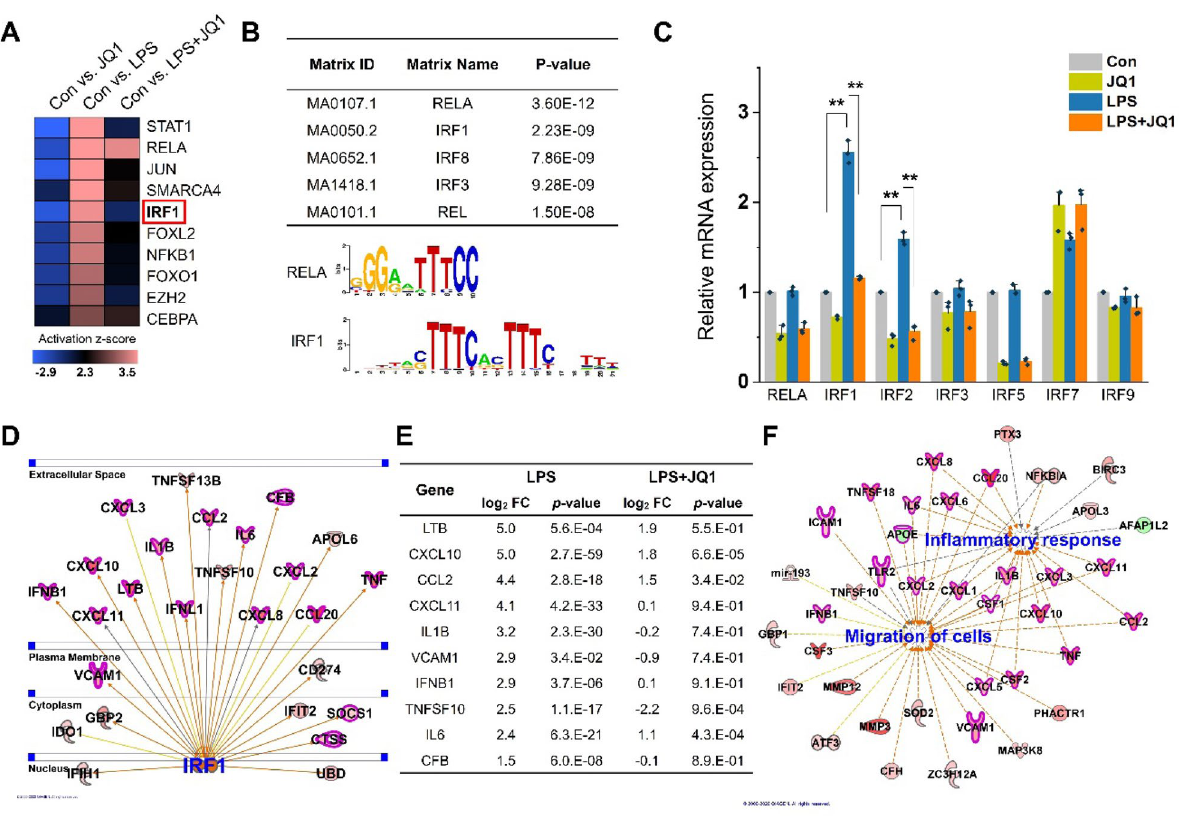
Figure 5. IRF1 regulates migration-related genes in LPS- and LPS + JQ1-treated HMC3 cells. ( A ) IPA upstream regulator analysis of DEGs in LPS-, JQ1- and LPS + JQ1-treated HMC3 cells. The color scale shown in the heat map represents the activation z-score value. ( B ) TF-binding motif analysis to determine TF-binding site enrichment in the promoters of migratory genes. Putative binding sites for IRF1was significantly enriched in LPS-induced migratory genes. ( C ) Expression of RELA and IRF family genes were analyzed by qRT- PCR and normalized to GAPDH transcript levels. Among these IRF family genes, IRF1 and IRF2 were significantly upregulated in LPS-treated cells. The data represent three independent experiments. The values are the mean ± SEM of triplicate experiments (** p < 0.001). ( D ) IPA upstream regulator analysis identified key regulatory gene IRF1, and it targets genes in LPS-treated cells. Of the genes regulated by IRF1, only migration- related genes are shown in bold and in red. The migration-related genes were highly correlated with IRF1. ( E ) Log 2 fold changes and p -value in the expression of IRF1 target genes. ( F ) IPA network analysis of genes related to the inflammatory response and migration in LPS-treated cells. Of the genes identified, only chemotaxis- related genes are shown in bold and in red. Most inflammation-related genes overlap with migration-related